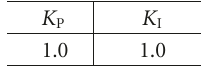
Table A.9: Parameters of a PI controller of test system 2.